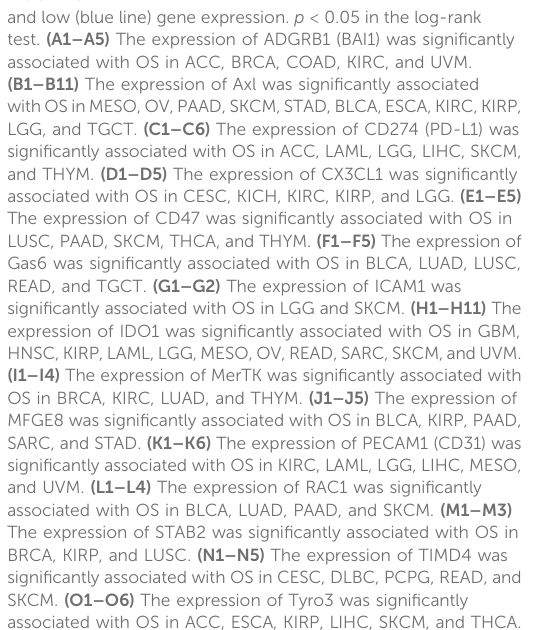
FIGURE 3 and low (blue line) gene expression. p < 0.05 in the